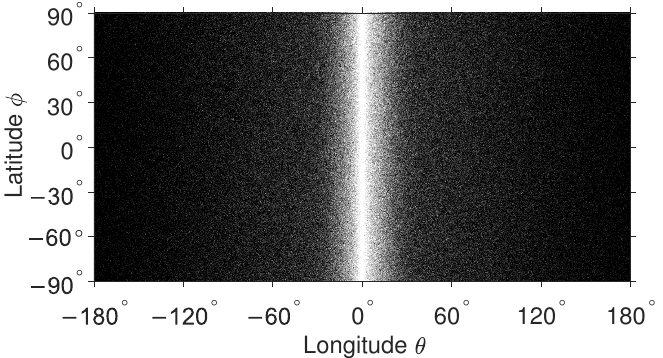
Figure 11. Binary map of random data hiding positions along the longitude (Black: Pixel used for data hiding; White: Pixel not used for data